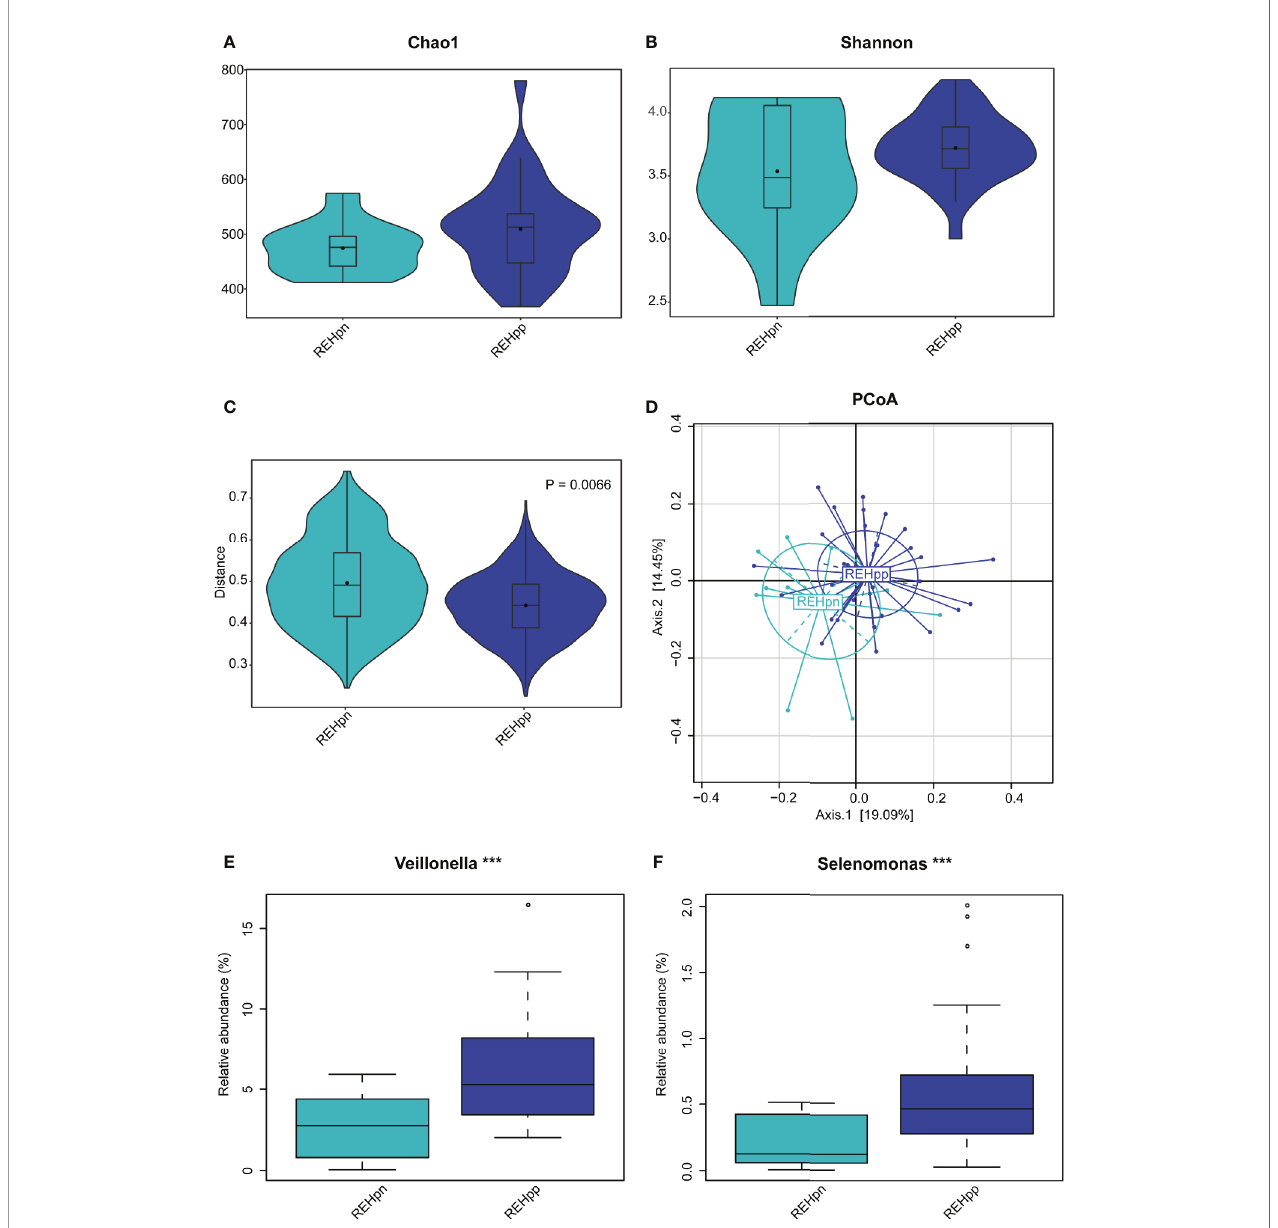
FIGURE 4 | The in fl uence of Hp infection on the oral microbiota of re fl ux esophagitis patients. The alpha diversity of the REHpp group tended to be higher than that of the REHpn group, but it was not signi fi cant, P > 0.05 (A, B) , and the beta diversity was signi fi cantly lower than that of the REHpn group, R 2 = 0.053, P = 0.0066 (C, D) . Comparison of bacterial abundance between the REHpn and REHpp groups at the genus level (E, F) , the abundances of Veillonella and Selenomonas in the REHpp group were signi fi cantly higher than those in the REHpn group, *** P <